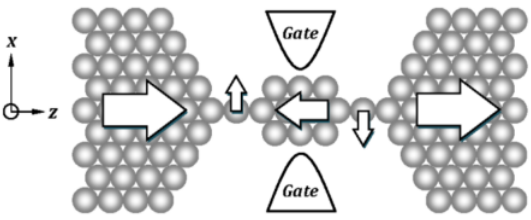
Fig. 1 . The considered structure of two atomic-size domain walls between two semi-infinite nanowires